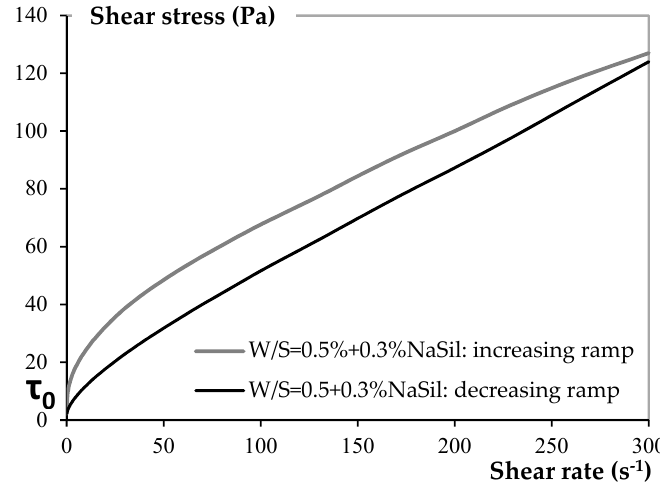
Figure 2. Flow curve of a clay paste prepared with 0.3% of NaSil.